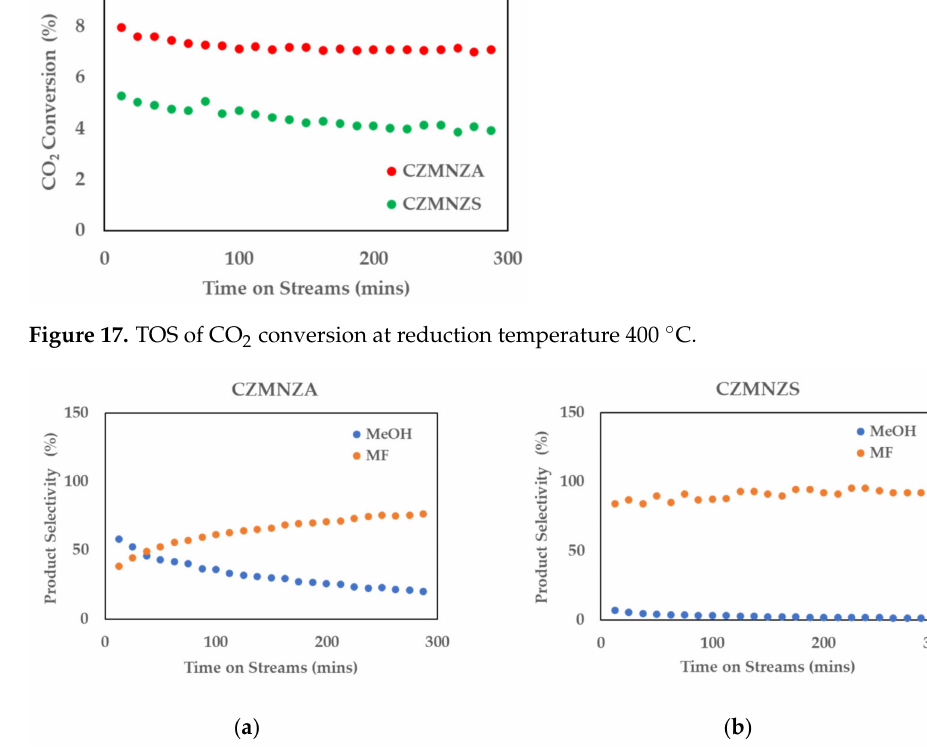
Figure 18. TOS of methanol and methyl formate selectivity for ( a ) CZMNZA ( b ) CZMNZS at reduction temperature 400 ◦